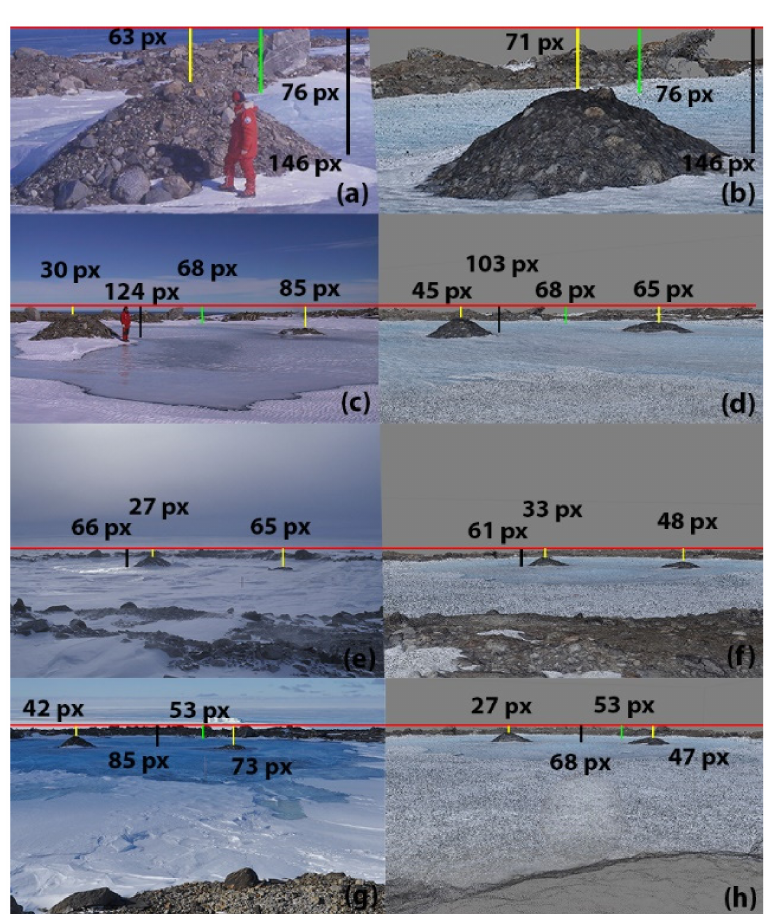
Figure 2. Comparison of heights in pixel between the frost blisters M1 (left), M2 (right) and ice references in different years. The matching accounts for images taken in 1996 ( a ), 2002 ( c ), 2004 ( e ), 2014 ( g ) and each respective shooting position of the ( c ) on the 30/12/2018 ( b , d , f , h ). The red line links the external fixed points (boulders), the yellow bars match the frost blisters heights, the green bars the lake ice level at its eastern border, the black bars the internal ice